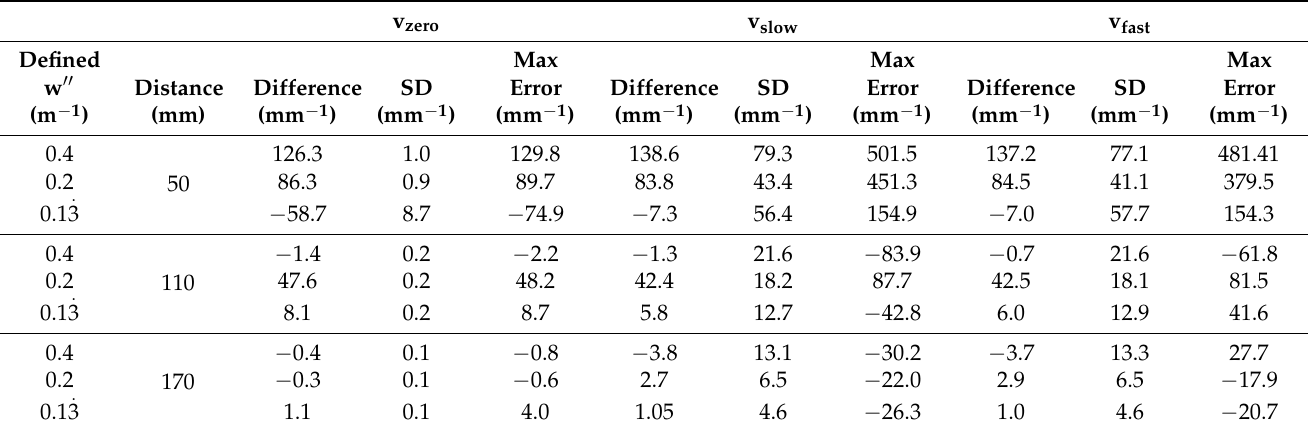
Table 1. Difference in the average calculated system measurement compared to the defined curvature from the calibration profile.